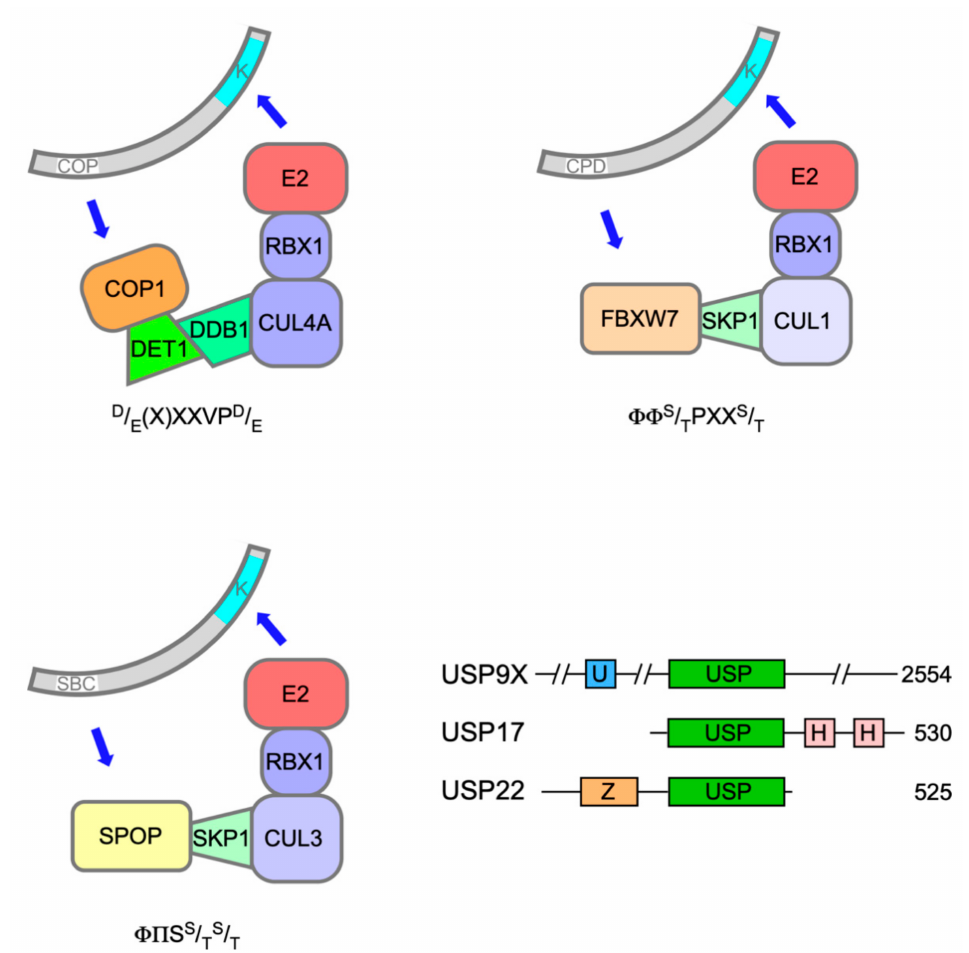
Figure 2. Subunit composition of E3 ligase complexes and domain structures of DUBs implicated in regulation of ETS protein activity. Each E3 ligase recognition subunit recruits its targets by means of a short consensus motif, indicated below each complex ( φ = hydrophobic; Π = hydrophilic), to allow transfer of ubiquitin from the bound E2 activating enzyme to one or more target lysines, predominantly within the ETS domain. Target phosphorylation within the consensus motif may be a prerequisite or an adjunct for binding, whereas phosphorylation of residues adjacent to the motif can inhibit binding (see text for details). DUBs implicated in ETS protein ubiquitination all share a conserved USP domain (green) with a catalytic triad of cysteine, histidine and aspartic acid residues (two in the case of USP9X), but few other recognised features in common. U, ubiquitin-like (UBL) domain (blue); H, hyaluranon binding motif (pink); Z, Zinc finger (peach). Numbers to the right indicate protein size in amino